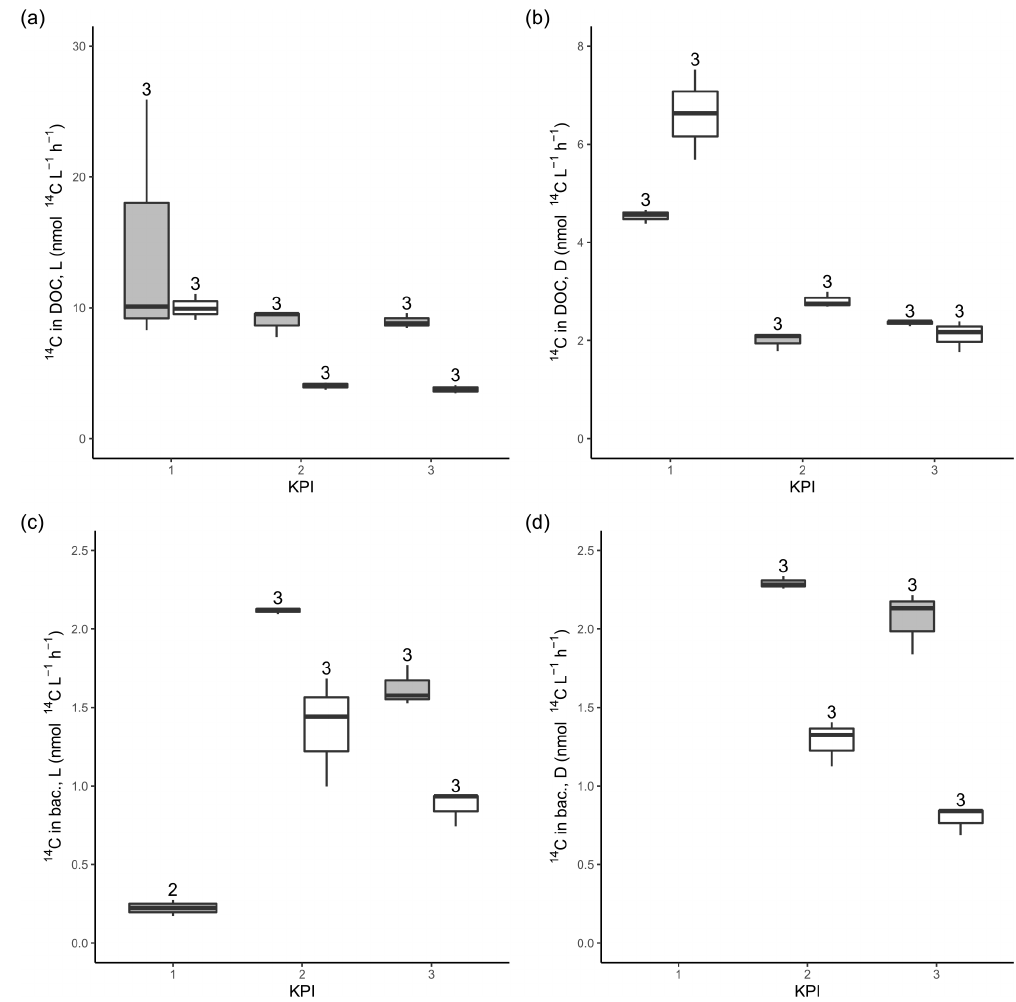
Figure A3. 14 C activity originating from 14 C-NaHCO 3 in the DOC pool in the filtrates from light (a) and dark (b) primary production incubation samples. 14 C activity originating from 14 C-NaHCO 3 in bacterial biomass after 4h of dark incubation of filtrate from light (c) and dark (d) primary production incubation samples amended with non-spiked cultures. The number above the boxplots shows the number of measurements. Lower and upper hinges of boxes mark the first and third quartiles, respectively, while the whiskers extend to the lowest and the highest values within 1.5 times the interquartile range. Grey boxes (left) show A. malmogiense , and white boxes (right) show R. marina